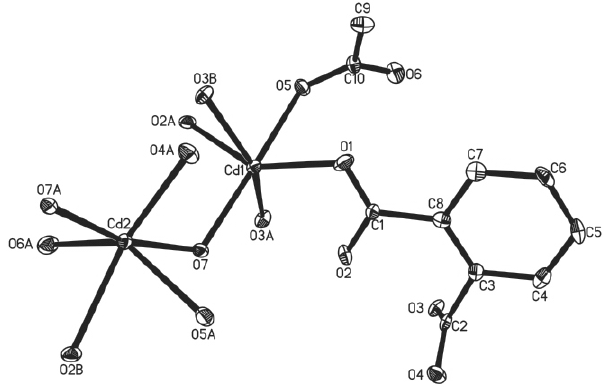
Table 1. Data collection and handling.